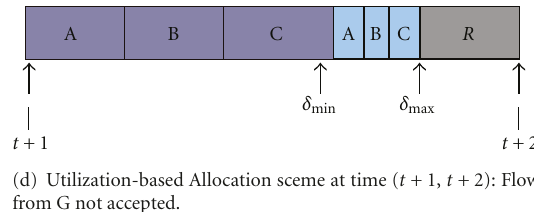
Figure 7: Channel Utilization observed by node C during every time period T. The channel bandwidth ρ ( υ − δ υ avoid channel